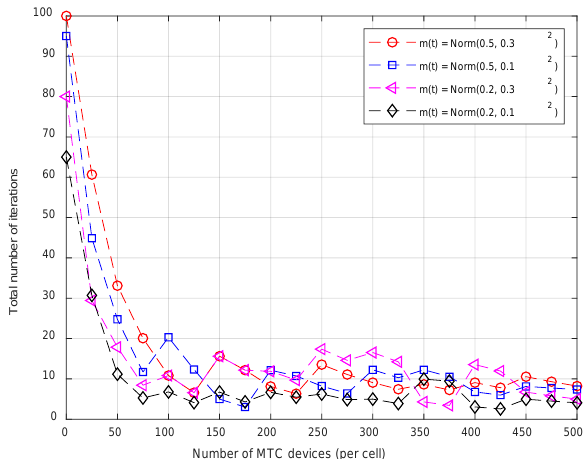
ff erent starting